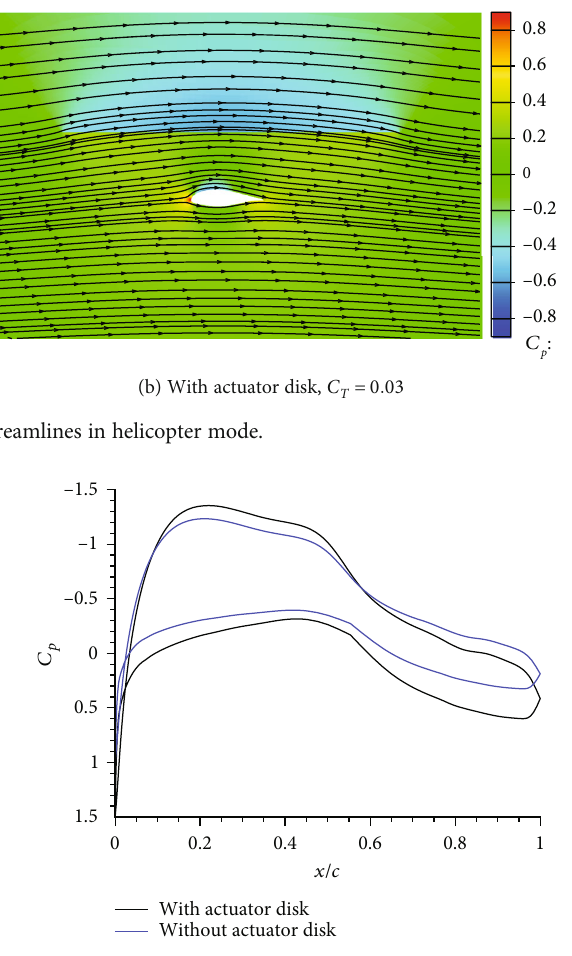
Figure 18: Pressure coe ffi cient distributions in airplane mode, with and without actuator